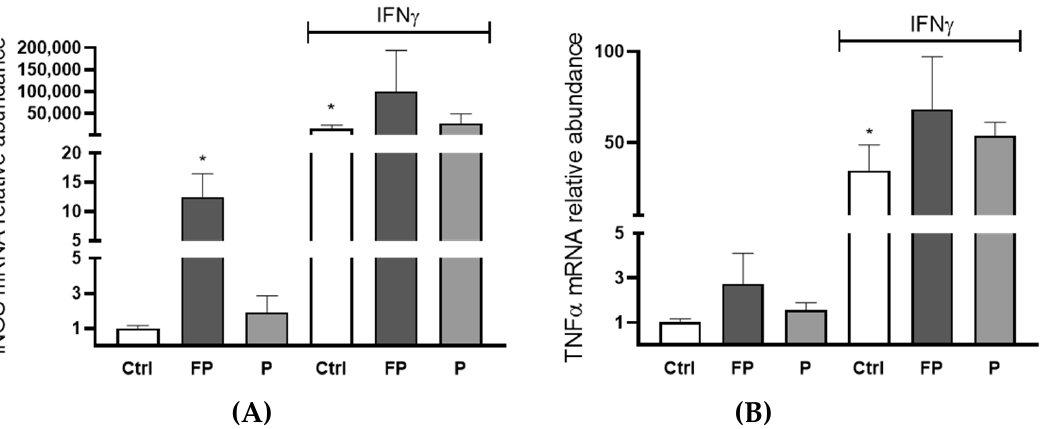
Figure 8. RAW 264.7 (4.0 × 10 5 /well) were seeded in six wells and incubated with 10 µg/mL of FP or P in the presence or absence of 100 U/mL of IFN- γ for 24 h. ( A ) iNOS and ( B ) TNF α genes expression was assessed using qRT-PCR analysis. Differences in gene expression were calculated using the 2 −∆∆ Ct formula and RPL13A as reference gene. Results are expressed as mean ± SD of at least three experiments. * p <0.05. significantly different from the ctrl. Ctrl (control, untreated cells); FP (cells treated with fermented Pushgay); P (cells treated with Pushgay); IFN- γ (cells treated with IFN γ ).